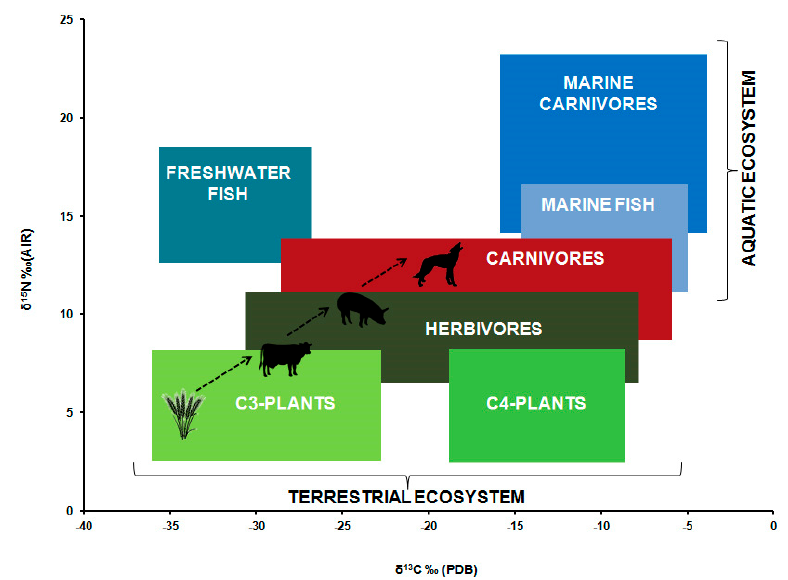
Figure 1. Terrestrial and aquatic food-web model for terrestrial and aquatic ecosystems with overlap ranges of carbon and nitrogen isotope values of different producers and consumers. According to the ecological niche model, food webs in different ecosystems are controlled by natural laws and work on the principle that each food level (e.g., plants, herbivores, omnivores, carnivores in the terrestrial ecosystem) occupies a particular niche in the overall food chain as exemplarily illustrated here (see also Appendix A). The trophic-level effect in the model is reflected by the accumulation of nitrogen in the food chain when individuals consume plants or animal products. The δ 15N in hu- man bone collagen is accumulated by an average of about three per mill compared to the fauna consumed. However, the complete nutritional spectrum of individuals and populations is based exclusively on a combination of the δ 13C and δ 15N values (mod. after Schoeninger & De Niro [28]). Dental calculus, like bones and teeth, remains preserved for millennia [29] and con- tains viruses and biomolecules from all areas of life [30] with the oral cavity serving as a long-term reservoir for bacteria that are responsible for local and systemic diseases [31]. Interestingly from a diagnostic point of view, systemic diseases such as diabetes are al- ways preceded by local oral pathologies. Genetic studies on dental calculus from prehis- toric and historical skeletal finds allow us to characterise specific DNA sequences [32]. This, in turn, has enabled us to identify food sources, pathogenically altered oral microbi- omes, opportunistic pathogens, human-associated antibiotic resistance genes and human and bacterial proteins. Thanks to the results obtained, periodontal pathogens such as Tan- nerella forsythia have been detected genetically, which has confirmed the suspected links between host immunity factors, “red complex” pathogens and periodontal disease [30]. Usually abundant in historical burials, dental calculus thus allows us to carry out parallel examinations of pathogen and host activities on the one hand and nutritional aspects on the other. Both the identification of plant remains in dental calculus and the palaeogenetic analysis of the oral microbiome [33,34] are innovative methods for anthropologists to study the procurement of food, nutrition, the pathogenic potential, and the behavioural patterns, and have also provided evidence of medically relevant uses of certain plants